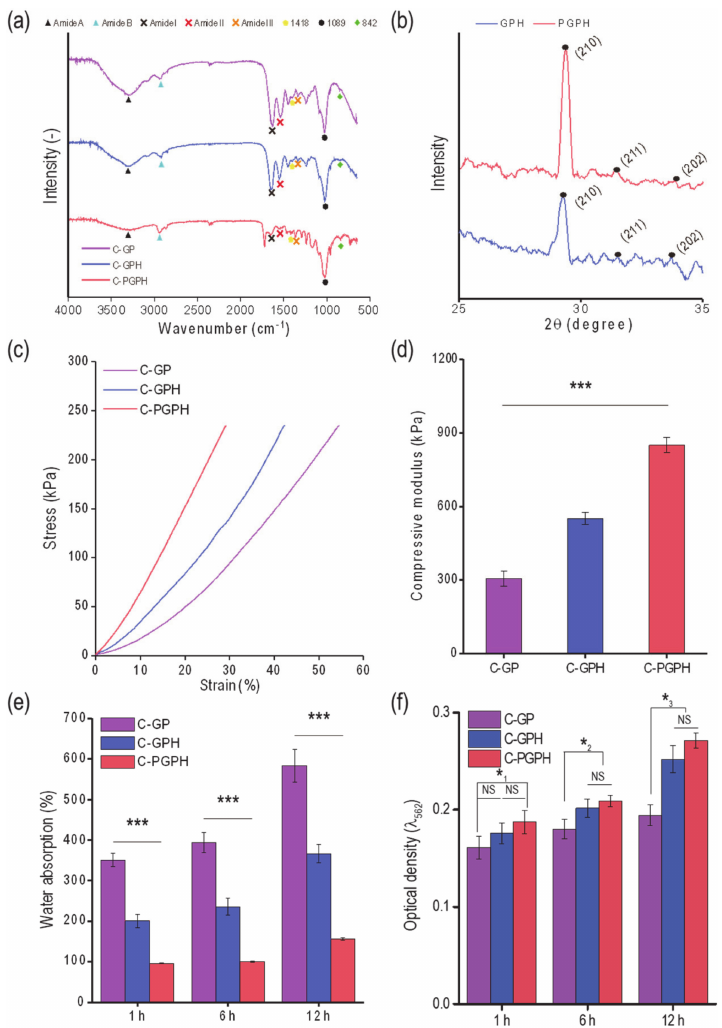
Figure 4. ( a ) Fourier-Transform Infrared (FTIR) spectra of sca ff olds (C-GP, C-GPH and C-PGPH), ( b ) XRD results for C-GPH and C-PGPH sca ff old. ( c ) Compressive stress-strain curves and ( d ) moduli of the sca ff olds. ( e ) Water uptake ability and ( f ) protein absorption of the sca ff olds at 1, 6 and 12 h. (NS > 0.05, p (* 1 ) = 0.011, p (* 2 ) = 0.006, p (* 3 ) = 0.006 and *** p <